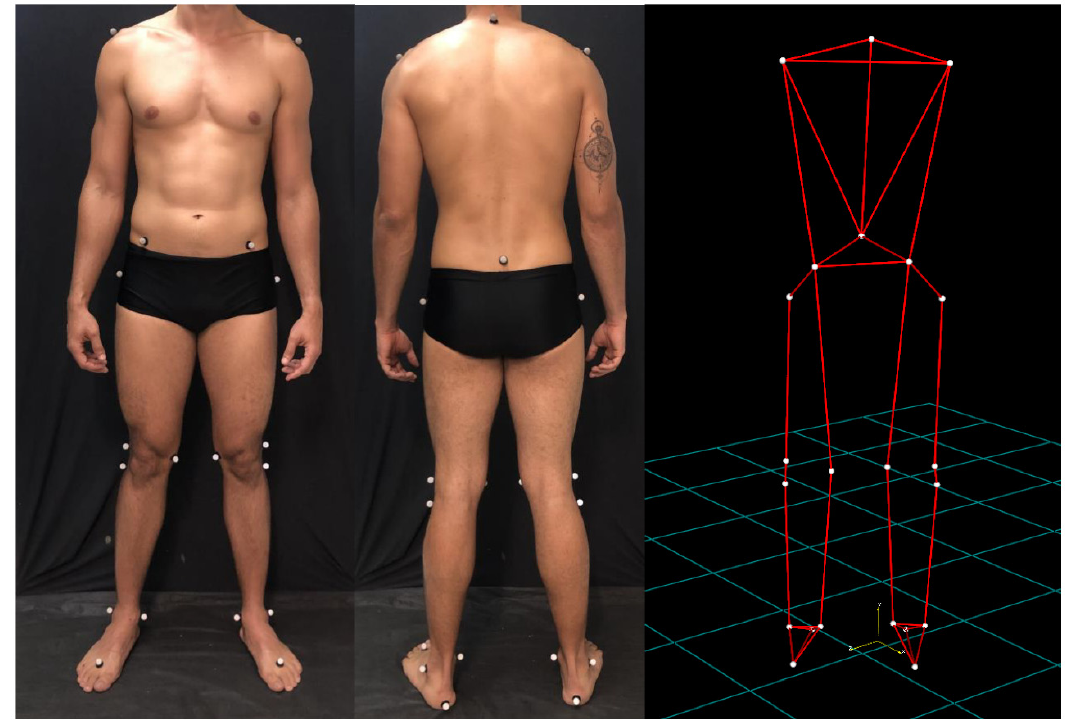
Figure 2. Placement of markers in the body the volunteer according to the Davis protocol.